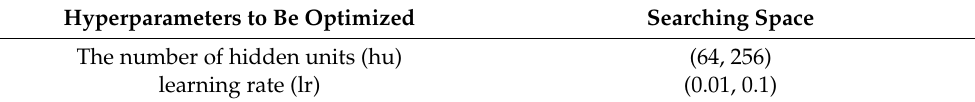
Table 1. The upper and lower search space corresponding to the hyperparameter to be optimized. Hyperparameters to Be